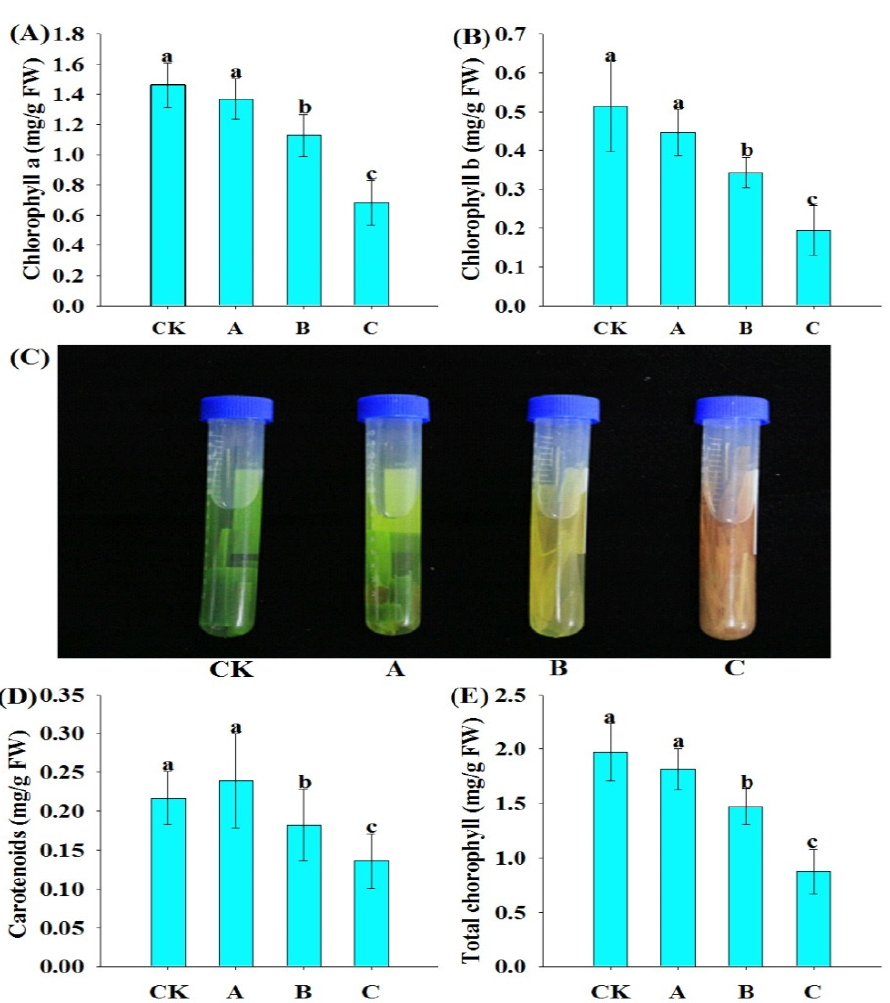
Figure 2. Effects of salinity and alkalinity stress on ( A ) chlorophyll a, ( B ) chlorophyll b, ( C ) Phenotypes of chlorophyll extract of wheat seedling leaves, ( D ) carotenoids, and ( E ) total chlorophyll of wheat seedlings. The bars represent the standard errors (±SE) of the four replicates. Different letters on the column represent significant difference among treatments ( p ≤ 0.05).